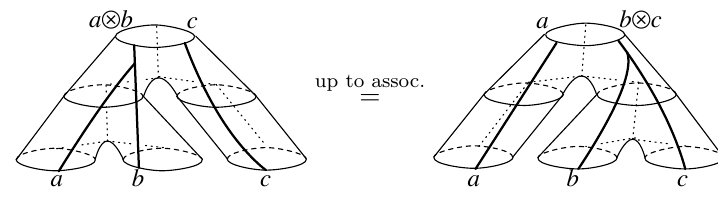
Figure 45 . The product M is twisted commutative.